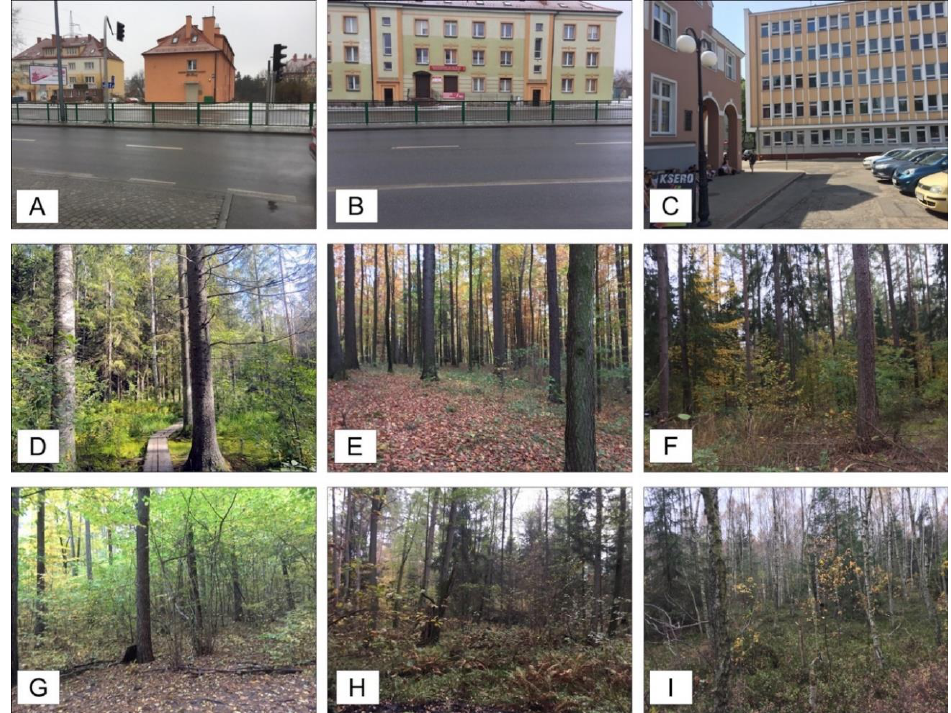
Figure 1. The photographs present three types of landscape: ( A – C ) present urban landscapes, ( D – F ) present forest landscapes and ( G – I ) present dense forest landscapes. Each photograph was used in this study for measuring preferred pleasantness.